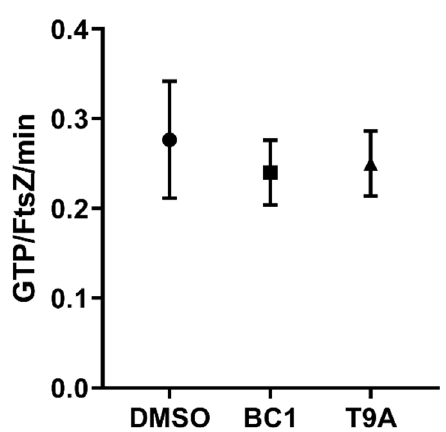
Figure 7. GTP hydrolysis activity of B. subtilis FtsZ in the presence of DMSO, BC1, or T9A.